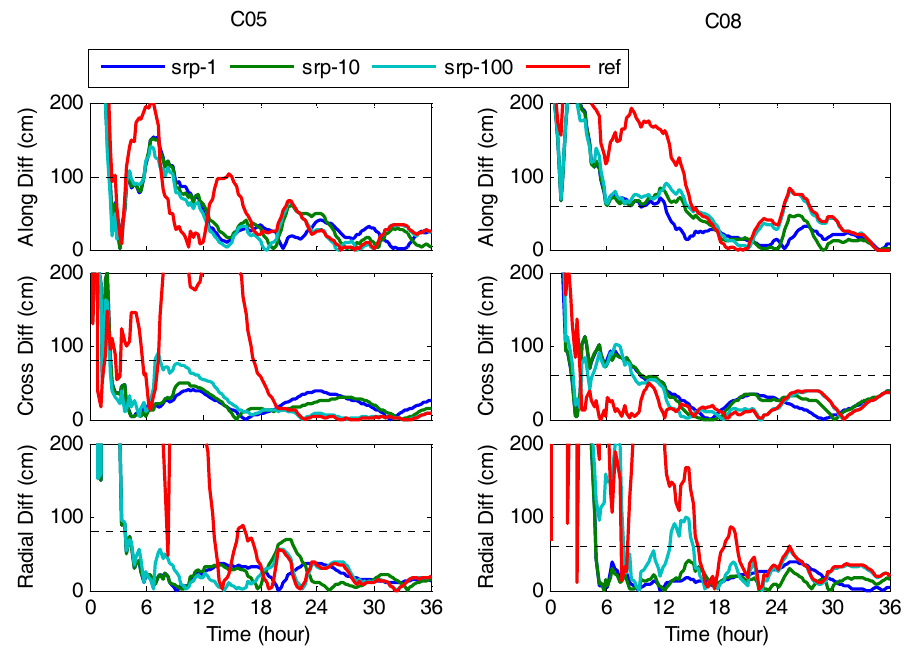
Figure 11. Time series of the orbit accuracy using different a priori STD of SRP parameters. The horizontal black dotted line represents the convergence criteria for each direction.